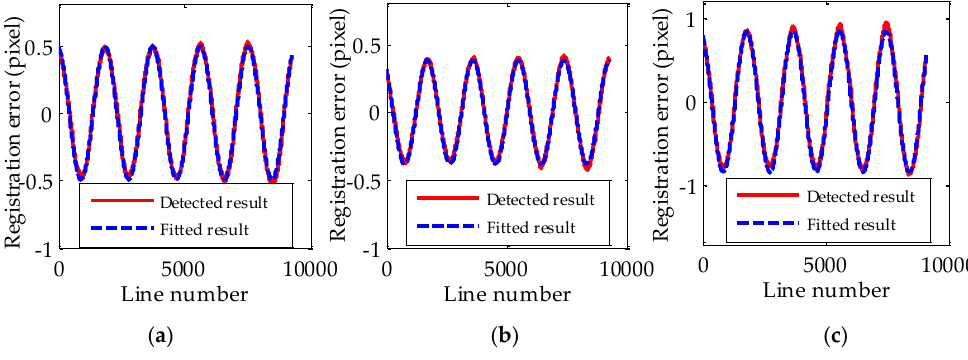
Figure 5. The relative registration error curves of different band combinations ( a ) B1-B2; ( b ) B2-B3; ( c ) B1-B3. Table 3. The parameters of registration error curves of different band combinations.